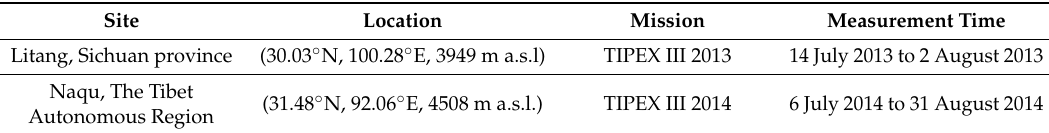
Figure 9. Locations of TIPEX III sites in Litang and Naqu. Map: Google Earth (January 2018). Table 3. Summary of the measurement of the water vapor, cloud and aerosol lidar.